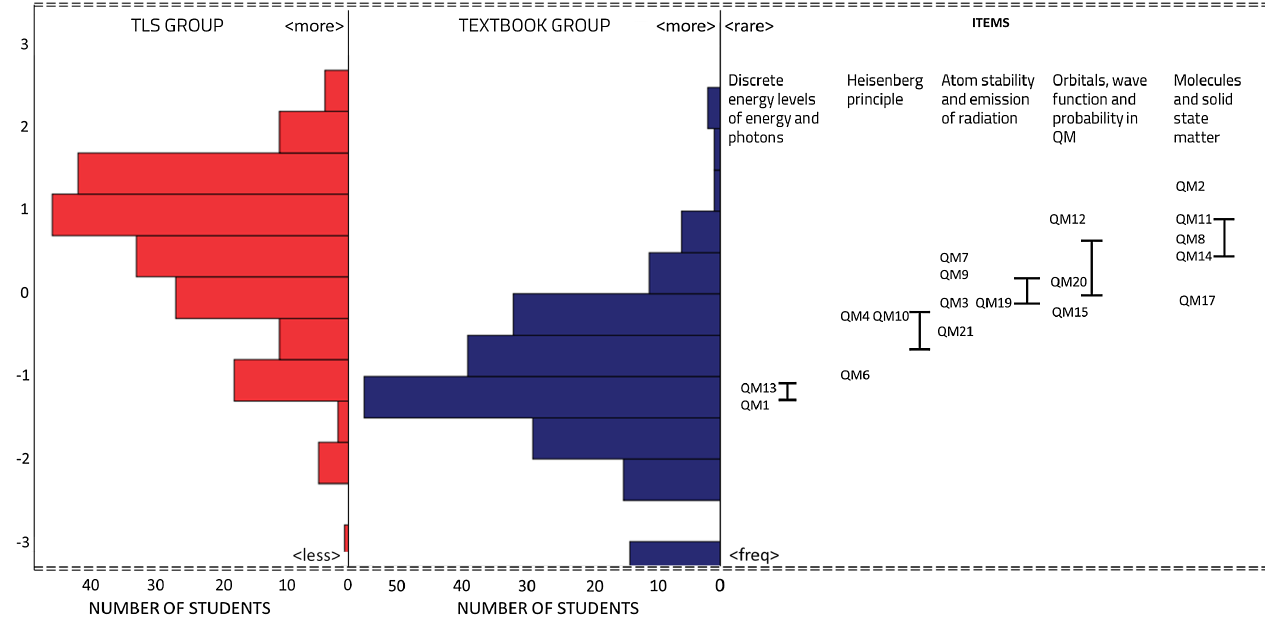
FIG. 1. Wright map of the questionnaire used in this study. Items are labeled as QM1, QM2, etc. Removed items (QM5, QM16, QM18, and QM 22) are not displayed. Items are grouped according to the levels of the construct map in Table I. Estimated difficulty of each of the five levels is indicated by whiskers. The error bar represents 1 standard